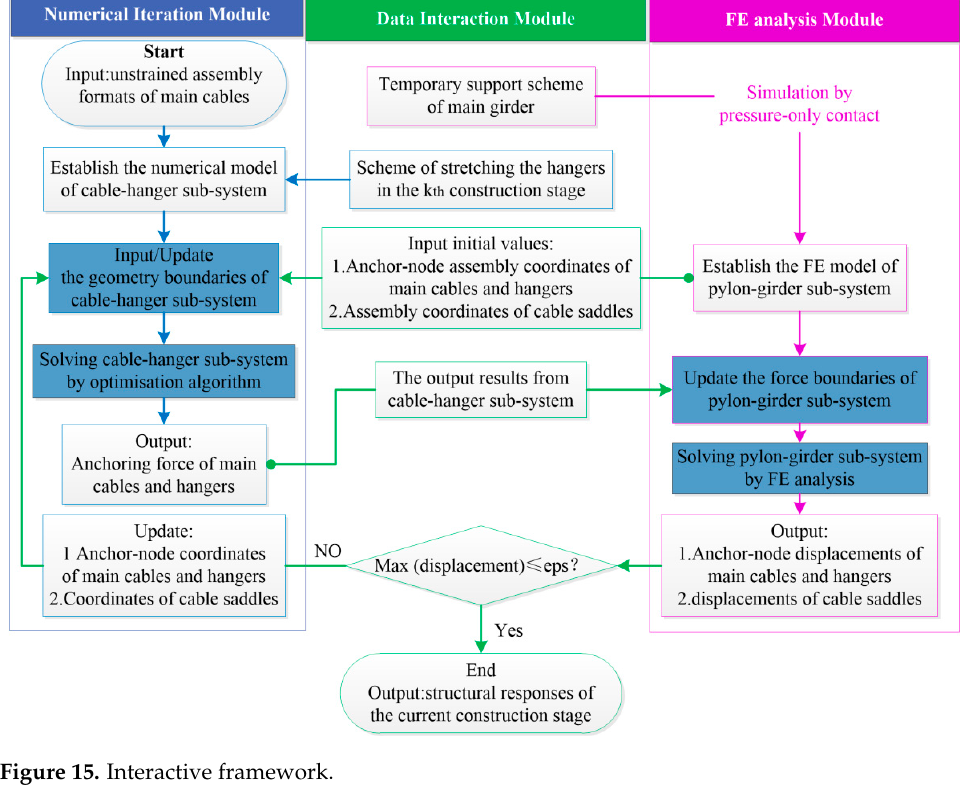
Figure 15. Interactive framework.